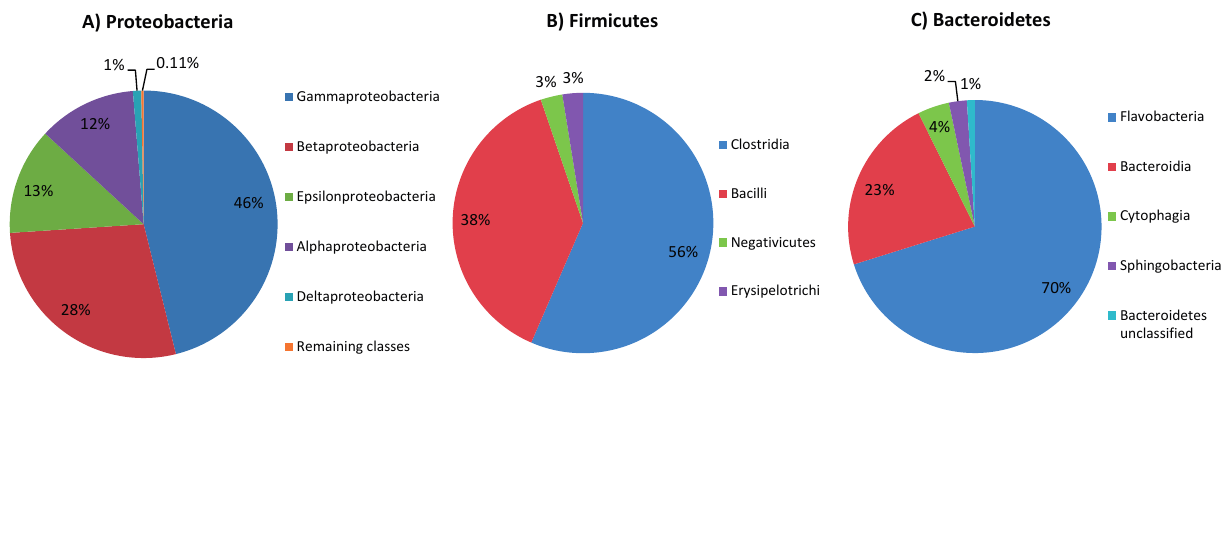
Figure 4. Phylogenomic class level characterization within the phyla ( A ) Proteobacteria ( B ) Firmicutes and ( C ) Bacteroidetes (from the digestive tract of P. pellucida ).